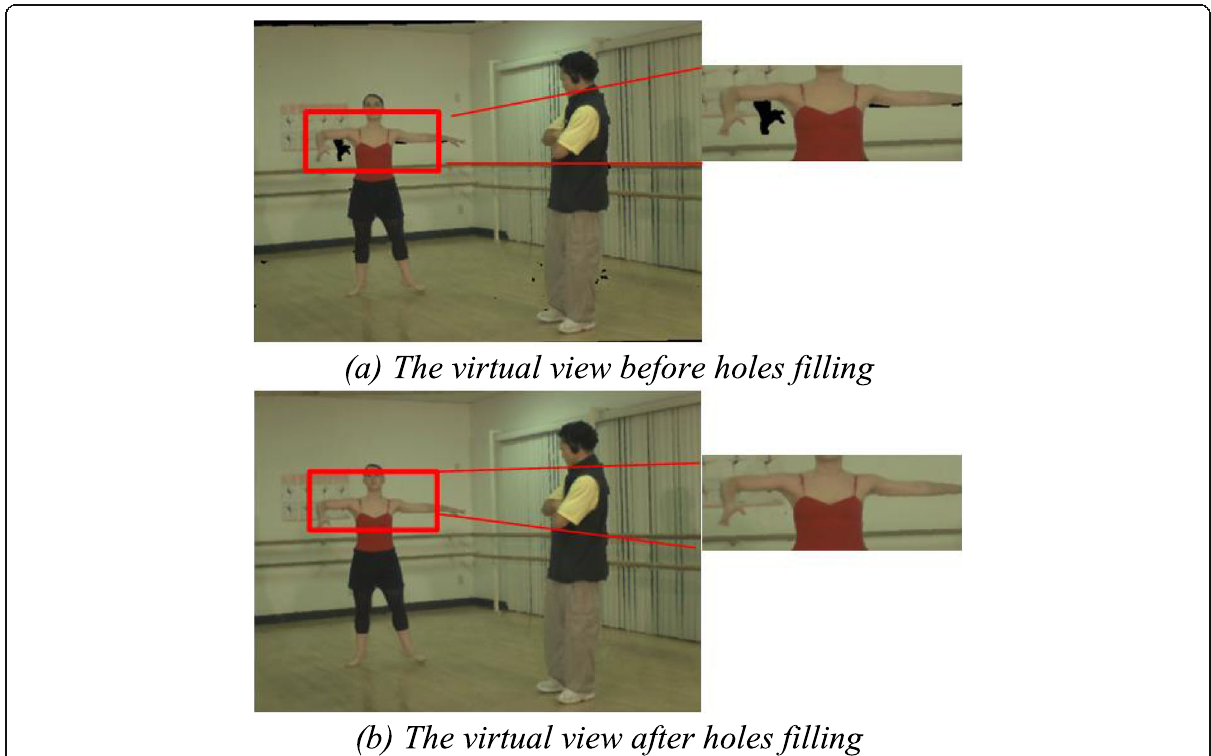
Fig. 7 Contrast of virtual images before and after holes filling. a The virtual view before holes filling. b The virtual view after holes filling